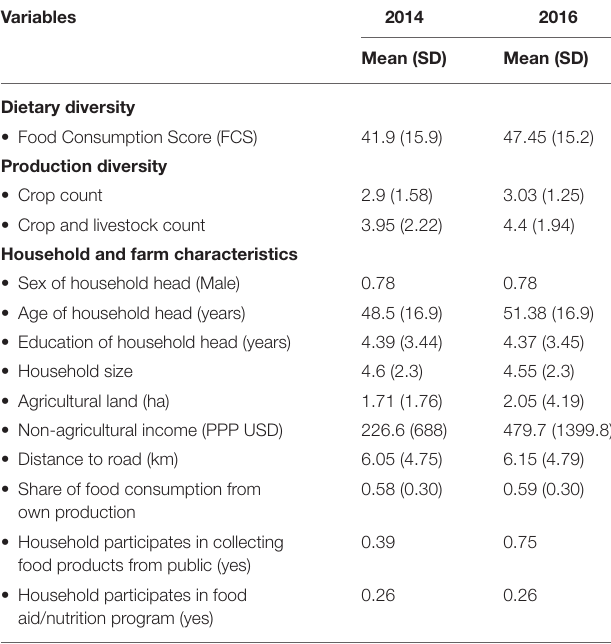
TABLE 1 | Descriptive statistics of variables characteristics for 2014 and 2016 survey data using aggregated sample from Dodoma and Morogoro